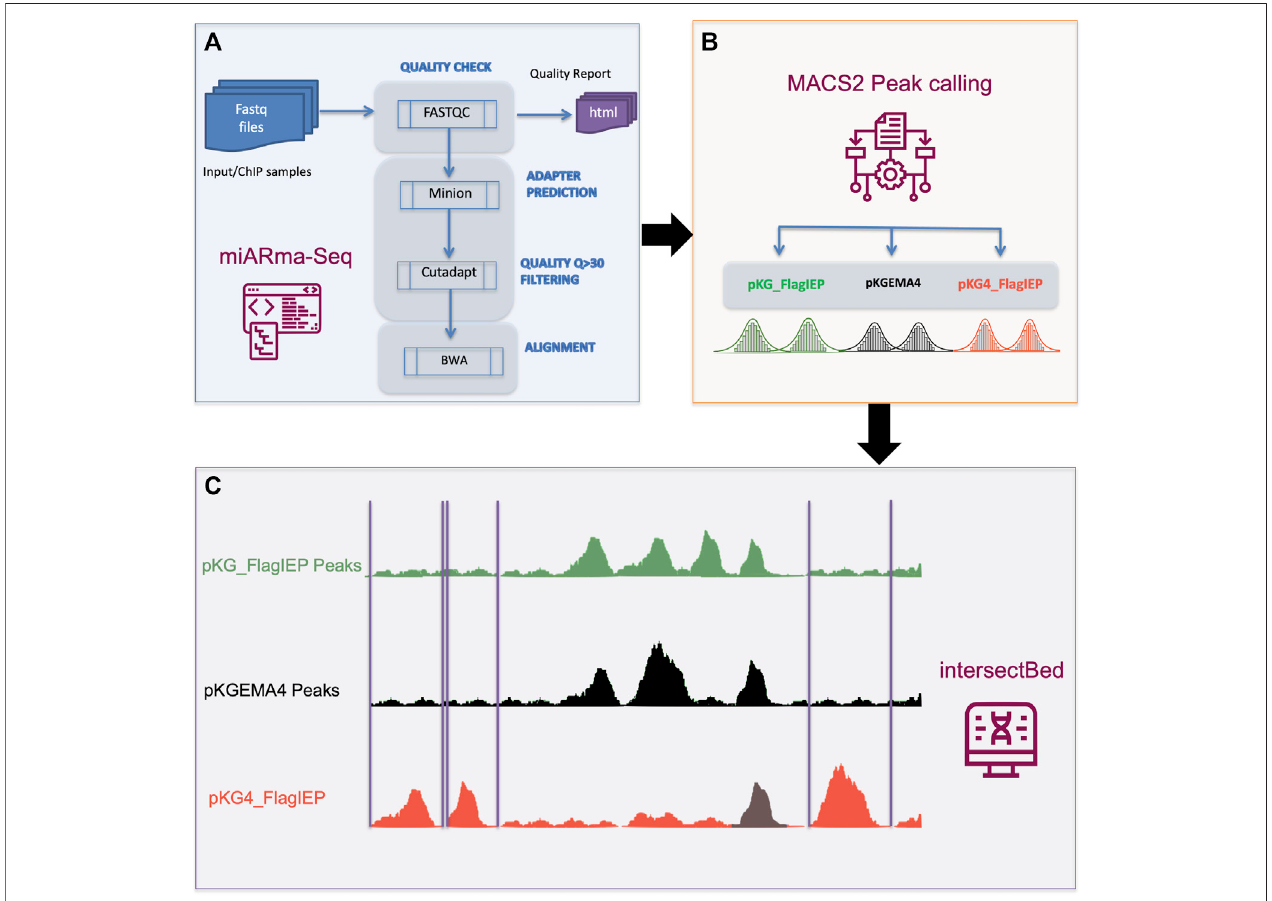
FIGURE3| ChIP-Seq dataanalysispipeline. (A) Qualityassessment and samplesalignmentwereperformedusing the miARma-Seq software. Fastqc0.11.5 was usedtostudytheoverallsequencequalityandtoidentifypossibleadapteraccumulation.Furthermore,weappliedminiontoidentifyanypossibleadaptersequences.As none werefound,weusedcutadapttoselectreadshaving aPhredscore > 30.Next,thosesequences werealignedusingBWA. (B) Resulting fi leswereprocessed with MACS2 to identify statically reliable peaks (FDR < 0.001) per each group of samples. (C) IntersectBed from bedtools were used to identify unique peaks in pKG4_FlagIEP by removing common peaks in pKG_FlagIEP or